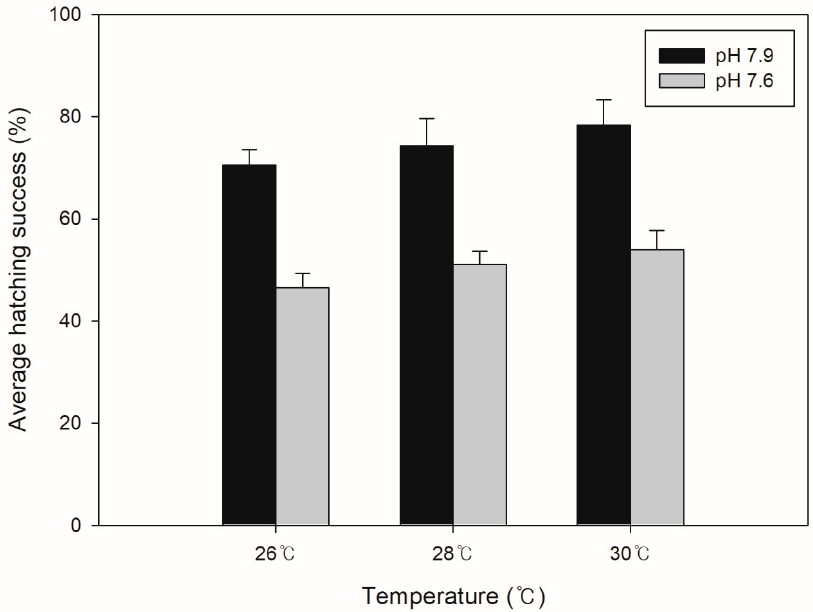
Figure 4. Hatching success of Acartia ohtsukai eggs when maintained under two different pH and three different temperature conditions.